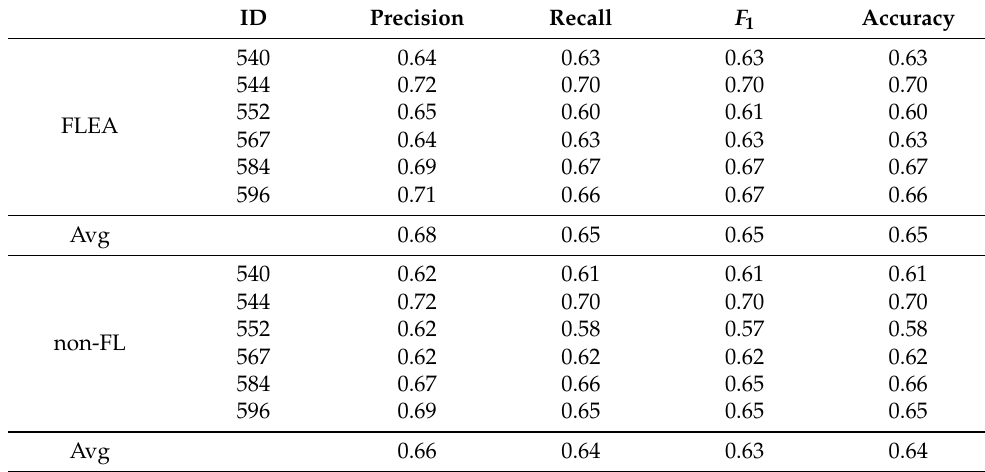
Table 8. Overall numerical scores over the testing sets of six new patients.